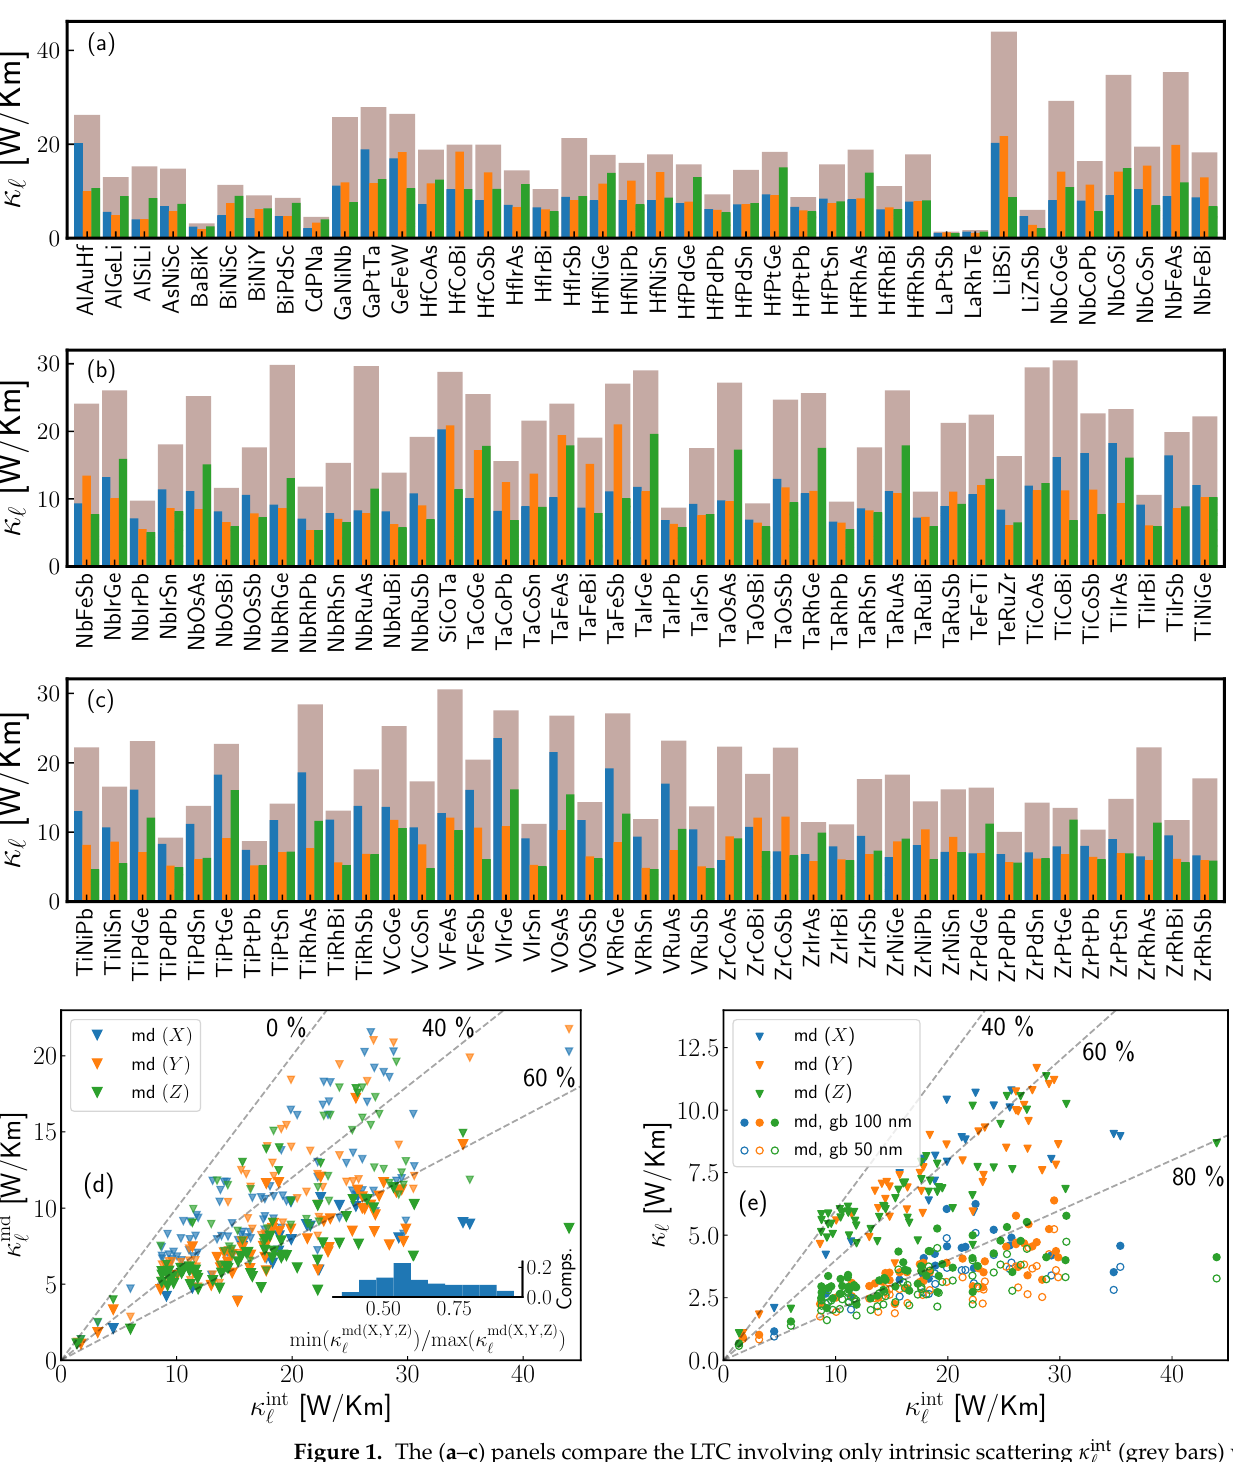
(cid:96) (grey bars) with ( X,Y,Z ) ) /max ( κ md ( X,Y,Z ) ) . In (cid:96) (cid:96)